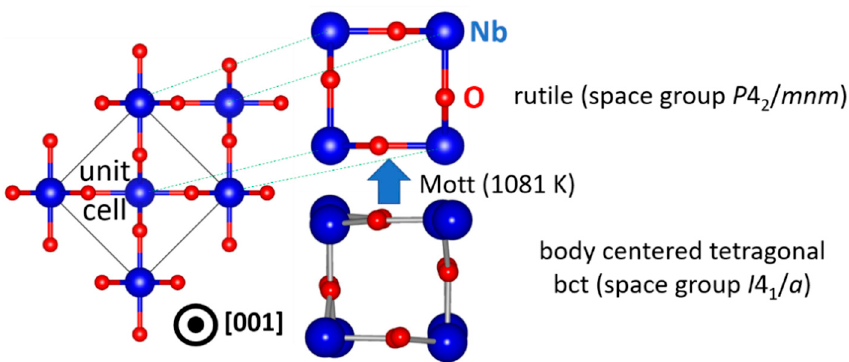
Figure 3. Mechanism of the Mott transition in NbO 2 . Symmetry breaking (disordered atomic positions in bct NbO 2 ) is disabled at elevated temperatures where the rutile structure is stabilized.